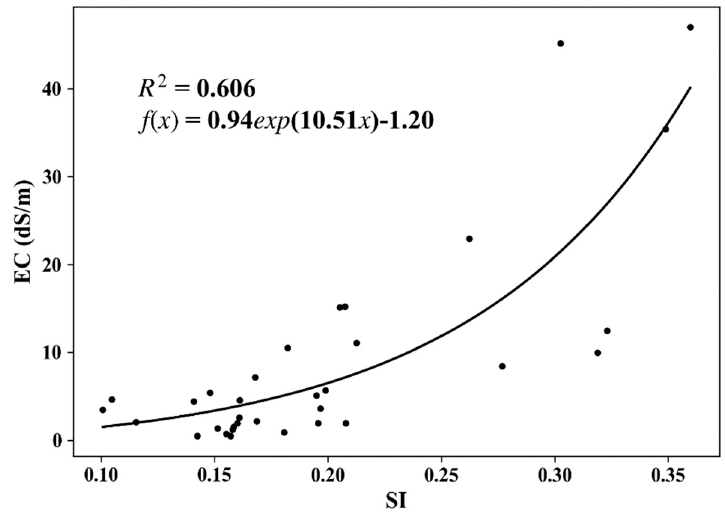
Figure 9. Exponential relationship between the SI (Sentinel 2) and measured EC. The SI was calculated from Sentinel 2 imagery from 22 April 2019 when the area was uncropped and unfrozen.